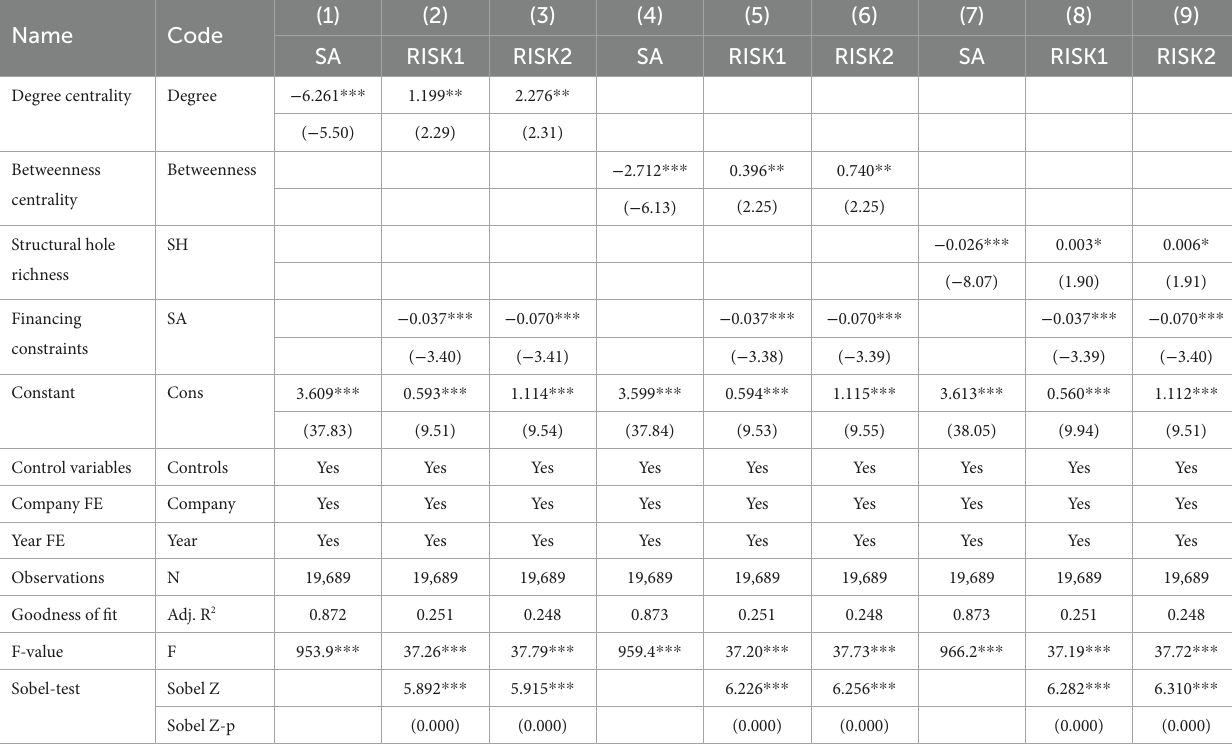
TABLE 9 Results of the mediating effect of SA.